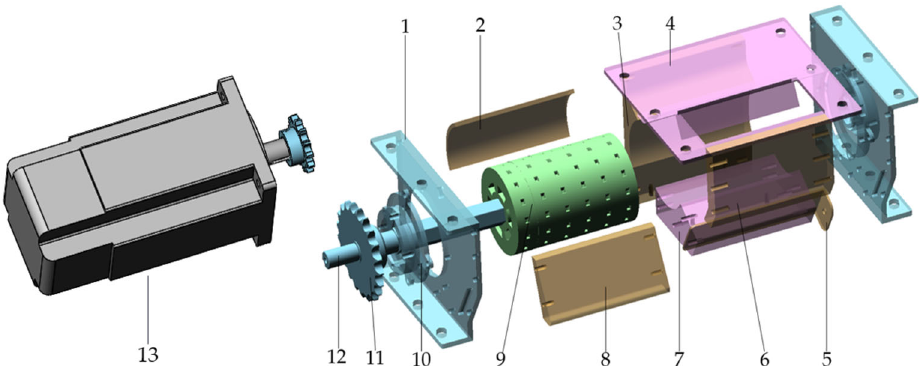
Figure 2. Structure of seed-metering device: (1) side panel, (2) seed-protecting plate, (3) rear motherboard, (4) connecting plate, (5) panel for unloading seeds, (6) front motherboard, (7) base, (8) regulating plate of seed layer, (9) seed-metering wheel, (10) bearing end-cap, (11) drive sprocket, (12) shaft, (13) electric